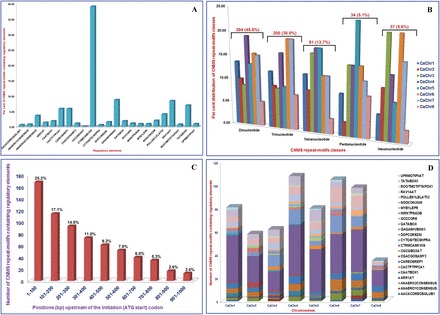
(A) Distribution frequency of CNMS repeat motifs containing gene regulatory elements in the chickpea genome. (B) Proportionate distribution of different CNMS repeat motif classes on the eight chickpea chromosomes. Dinucleotide CNMS repeats (45.6%) were the abundant microsatellite classes, followed by trinucleotide CNMS (30%) in the chickpea genome. (C) Positional distribution of CNMS repeat motifs carrying regulatory elements in the non-coding sequences upstream of the translation initiation codons (ATG) of chickpea genes. (D) Proportionate distribution of different CNMS repeat motifs containing gene regulatory elements on the eight chickpea chromosomes. The detailed characteristics of these regulatory elements and CNMS are described in Supplementary Table S2 at JXB online. (This figure is available in colour at JXB online.)